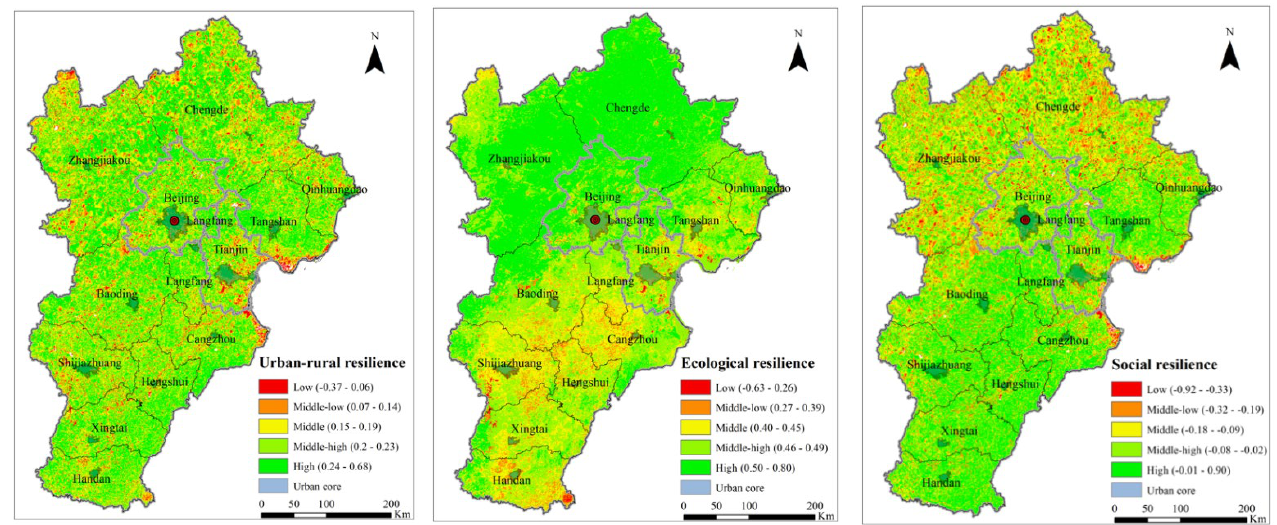
Figure 4. Spatial pattern of urban–rural resilience in the BTHUA.